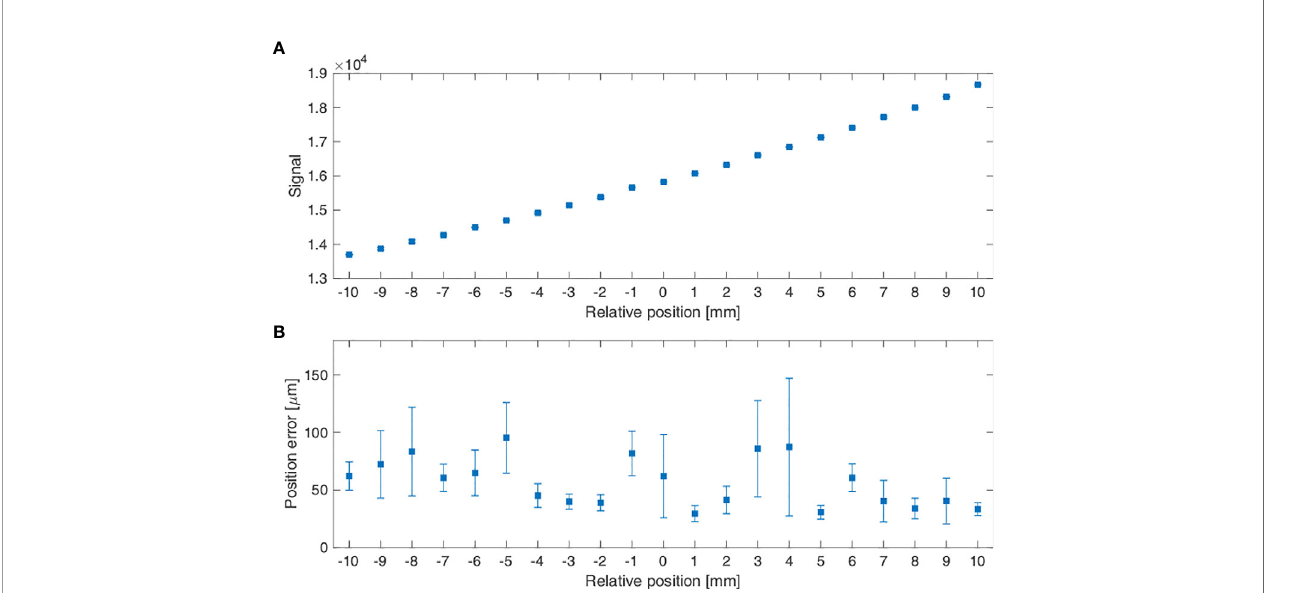
FIGURE 8 | Measurement signal re fl ecting the phantom position change: (A) Average signal according to the sensor ’ s relative positions and (B) The sensor ’ s position errors according to its relative position.